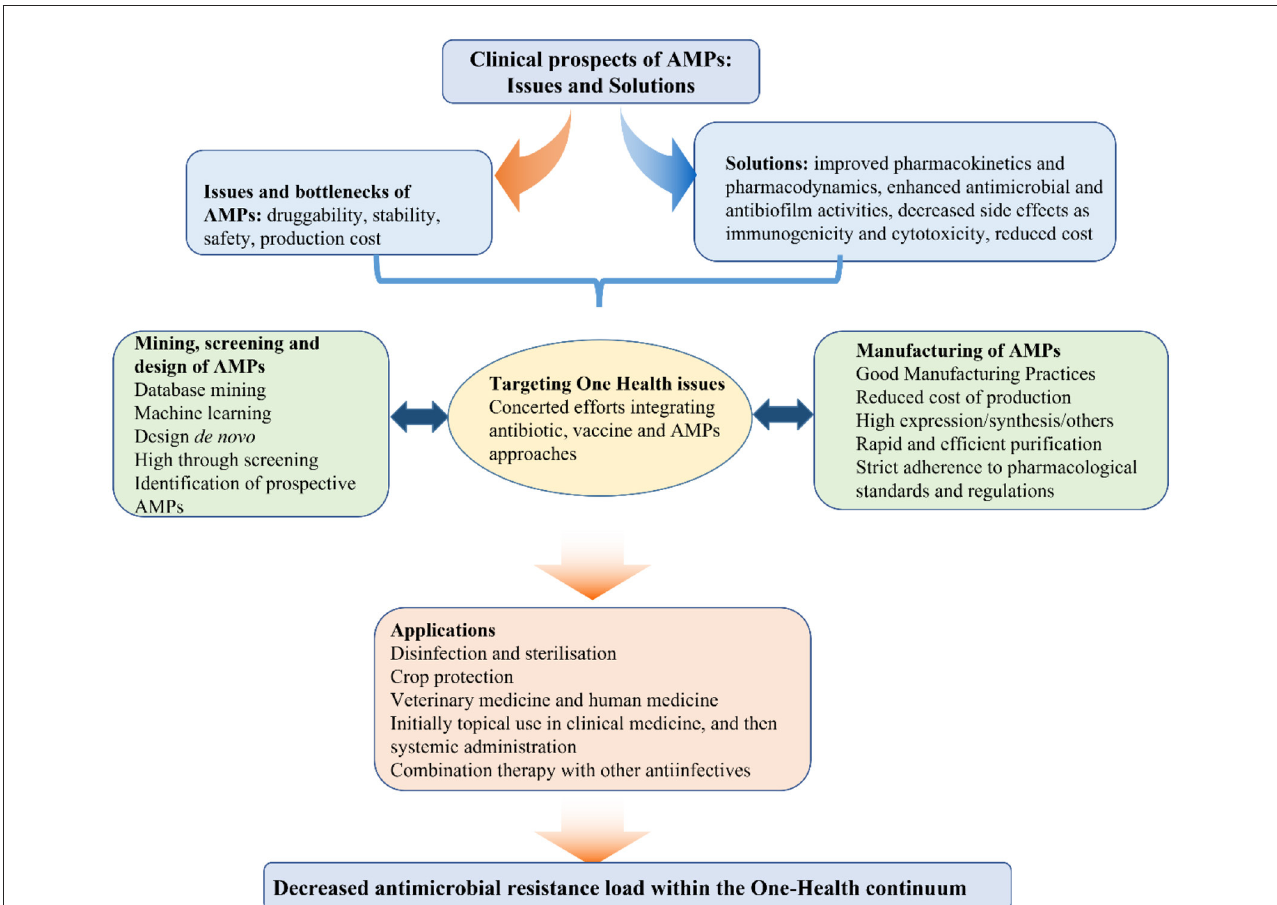
FIGURE1 Framework of AMPs development for the post-antibiotic